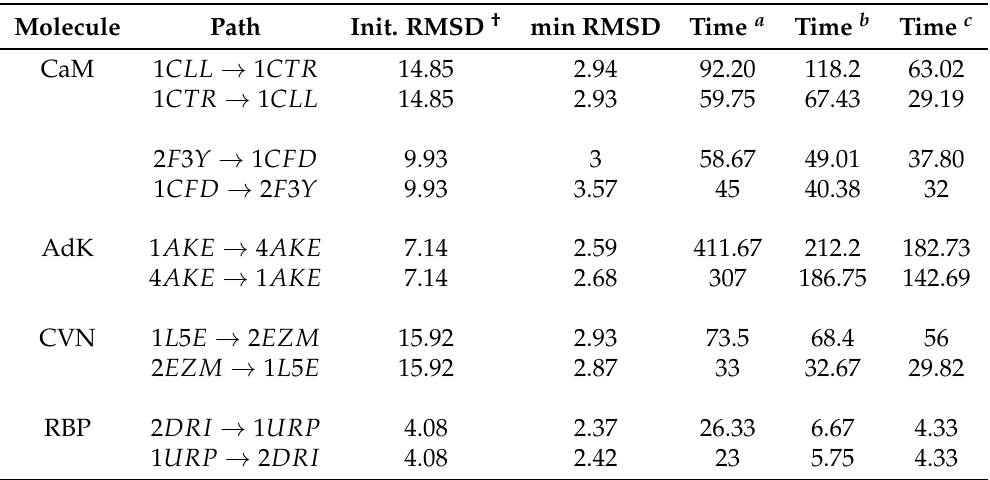
Table 1. Performance and comparison of the results.